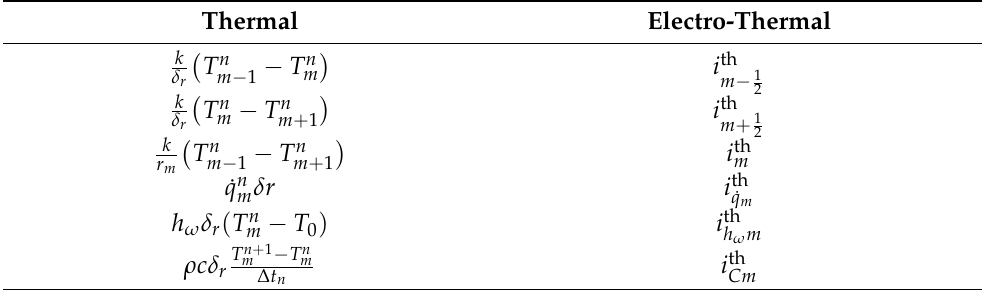
Table 2. Analog electrical and thermal current densities (in W · m − 2